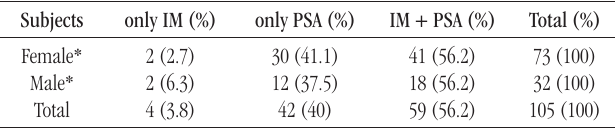
taBLE 2 − Prevalence of intestinal metaplasia and pseudoantral metaplasia in atrophic gastric mucosa of patients ( n = 105) with ABG